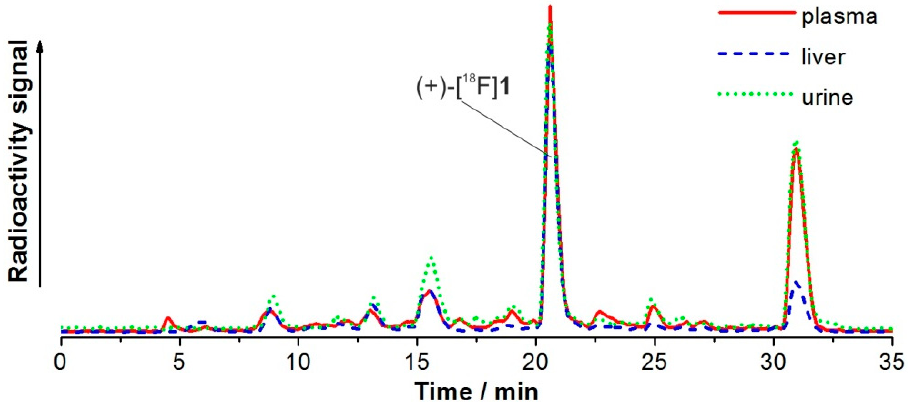
Figure 11. Radiochromatograms (method III) of acetonitrile extracts after injection of (+)-[ 18 F] 1 in CD-1 mouse (30 min p.i.).